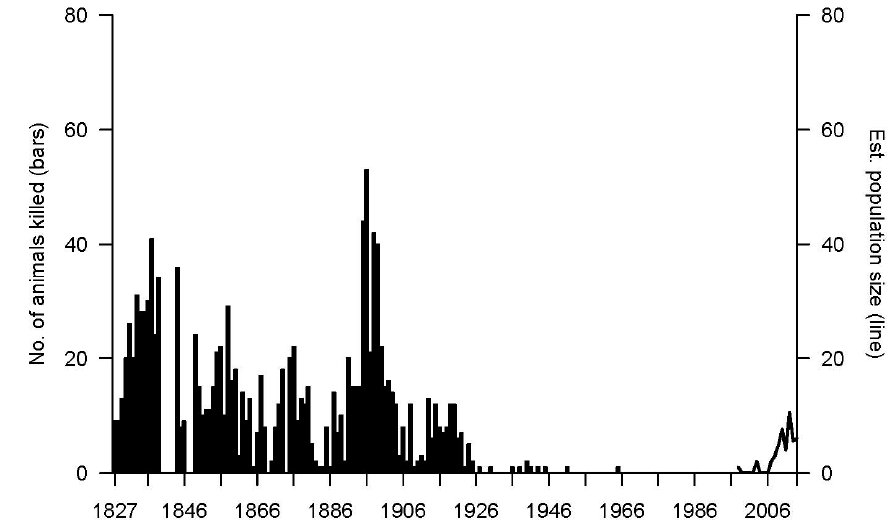
Figure 4. Number of wolves killed 1827–1965 (no data available for 1840–1843 and 1847–1848) in Jämtland (bars). Wolf population size based on yearly winter counts 1998/1999–2014/2015 in Jämtland (line). Sources: Swedish National Forest Service and Wildlife Damage Centre. Please note that the bounty data end in 1965 and winter counts start in the winter1998/1999.